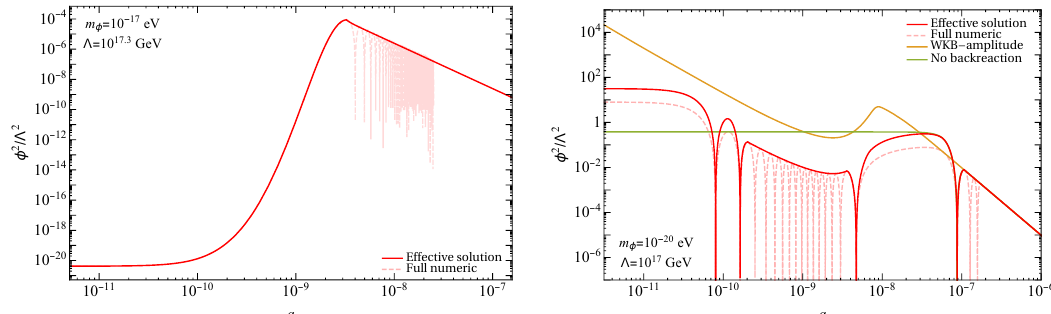
Figure 2 : Left: evolution of φ 2 / Λ 2 as a function of scale factor a for the negative coupling and parameters m = 10 − 17 eV, Λ = 10 17 . 3 GeV. The red-dashed curve shows the full φ numeric solution whereas the solid red curve shows the effective solution which patches together the oscillations with an exponential growth. Right: evolution of φ 2 / Λ 2 as a func- tion of scale factor a for positive coupling and parameters m = 10 − 20 eV, Λ = 10 17 GeV. φ The red-dashed curve shows the full numeric solution whereas the red solid curve gives the effective solution which patches together the slowly oscillating/frozen phase with a WKB- type solution in the intermediate regime. The pure WKB amplitude, neglecting Hubble friction, is shown in orange. The green curve shows the evolution of the φ -field neglecting the induced